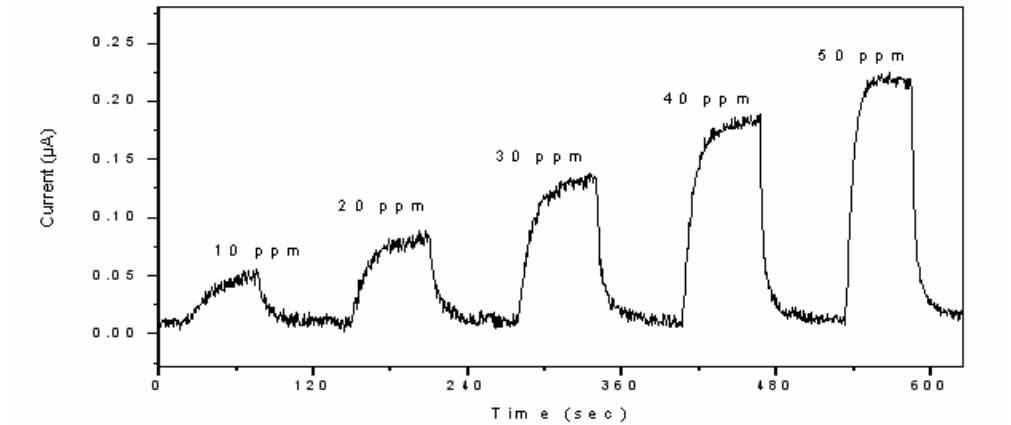
Figure 10. Response behaviour of the Pt | Nafion electrode sensor element with an area of 2 cm 2 prepared from 0.01 M Pt(NH concentration range of 10-50 ppm.